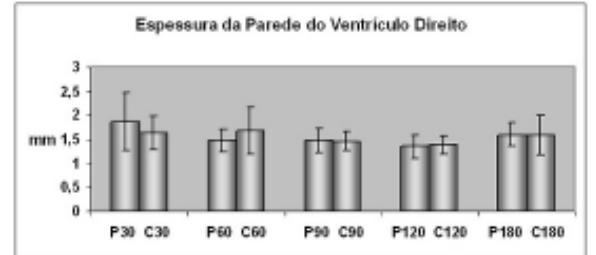
Fig. 5 – Espessura média da parede do ventrículo direito (em mm), nos grupos papaína e controle, nos diferentes períodos